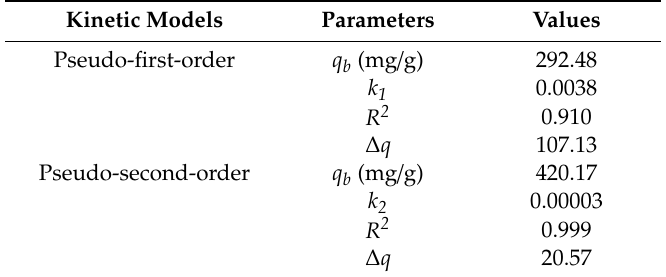
Table 1. The parameters of the pseudo-first-order and pseudo-second-order kinetic models.